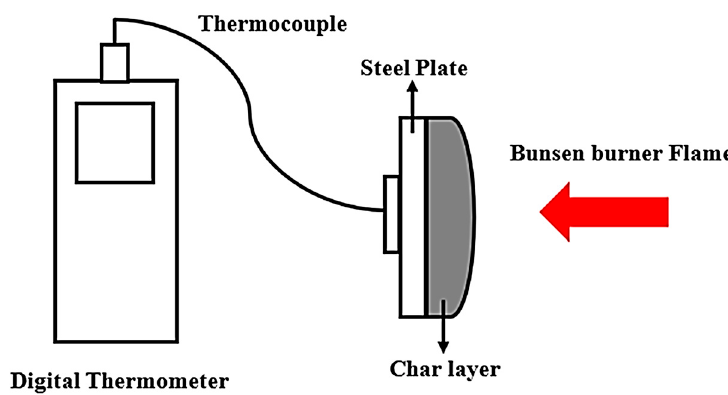
Figure 2. Schematic of the experimental setup for coated samples.